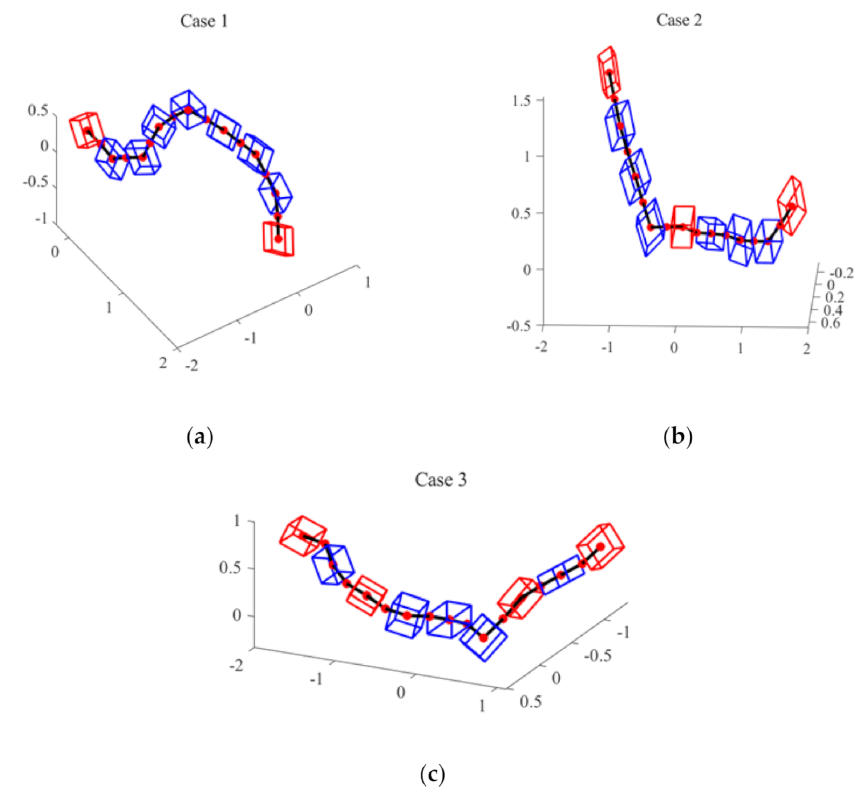
Figure 6. Configurations of the SMSRS under the solutions of the SHCP algorithm. ( a ) Case 1; ( b ) Case 2; ( c ) Case